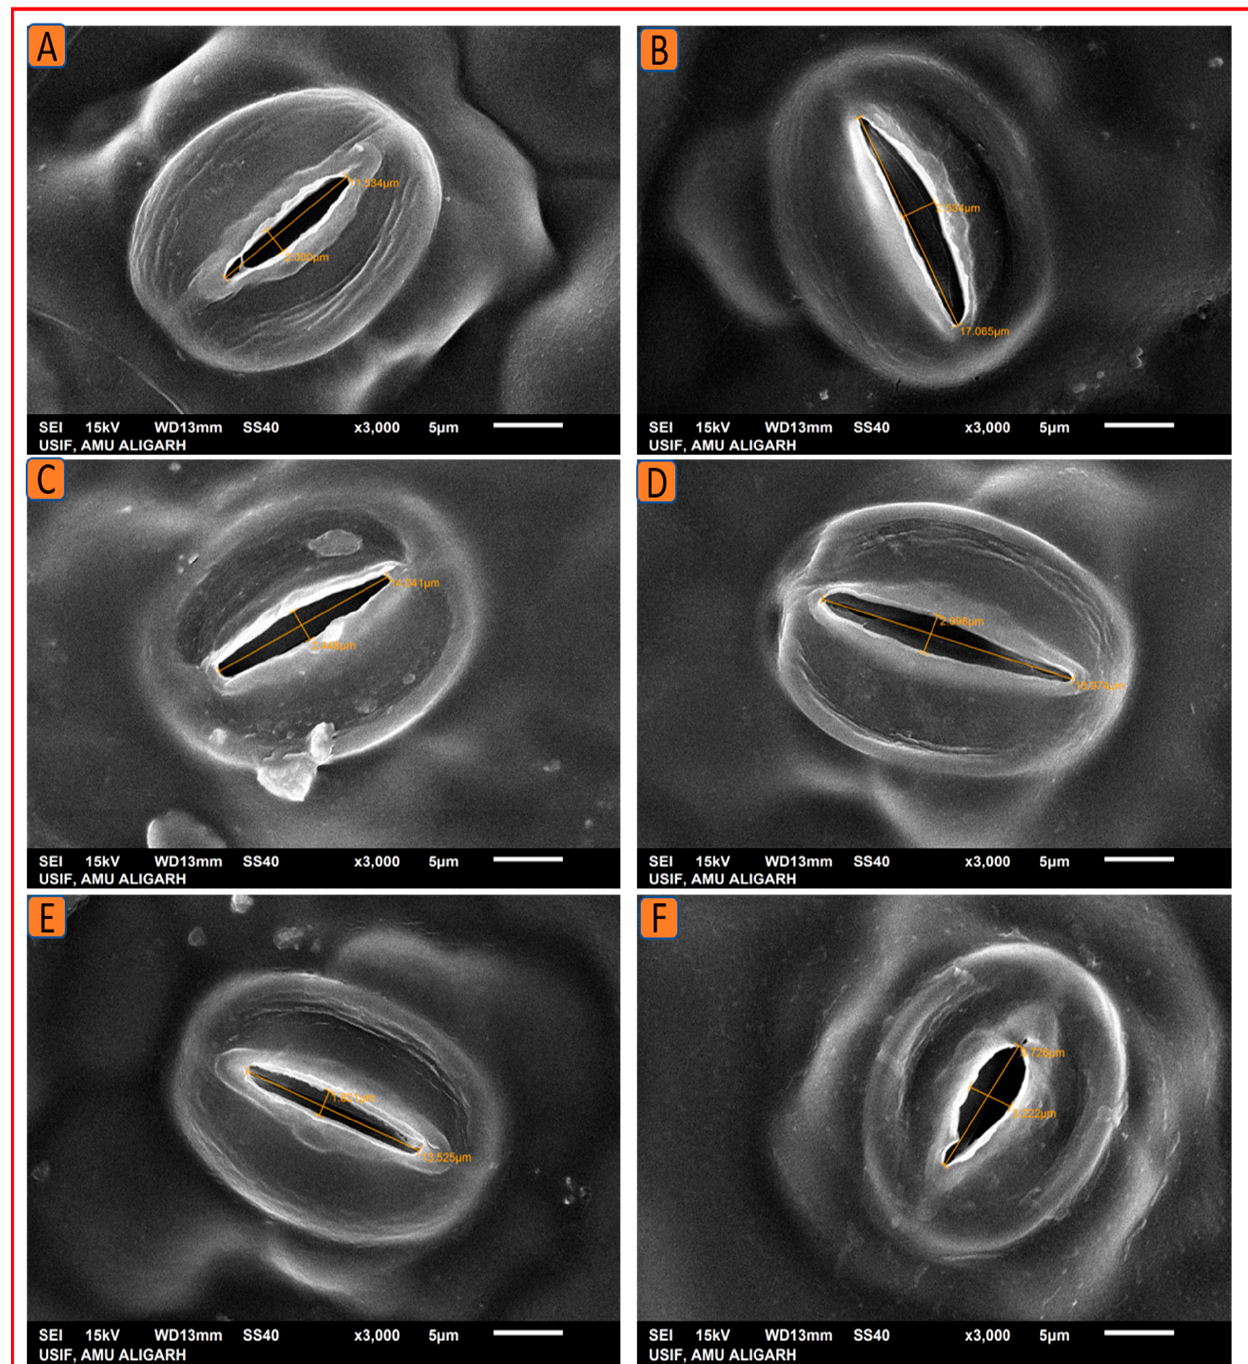
Figure 9. SEM micrographs depicting the stomatal behavior of the three studied peppermint cultivars. The SEM micrographs confirmed an increase in the stomatal dimensions in all three cultivars which had received the N application. ( A ) Stomatal aperture size at 0% N in Kukrail, ( B ) at 1.5% N in Kukrail, ( C ) at 0% N in Pranjal, ( D ) at 1.5% N in Pranjal, ( E ) at 0% N in Tushar, ( F ) at 1.5% N in Tushar.